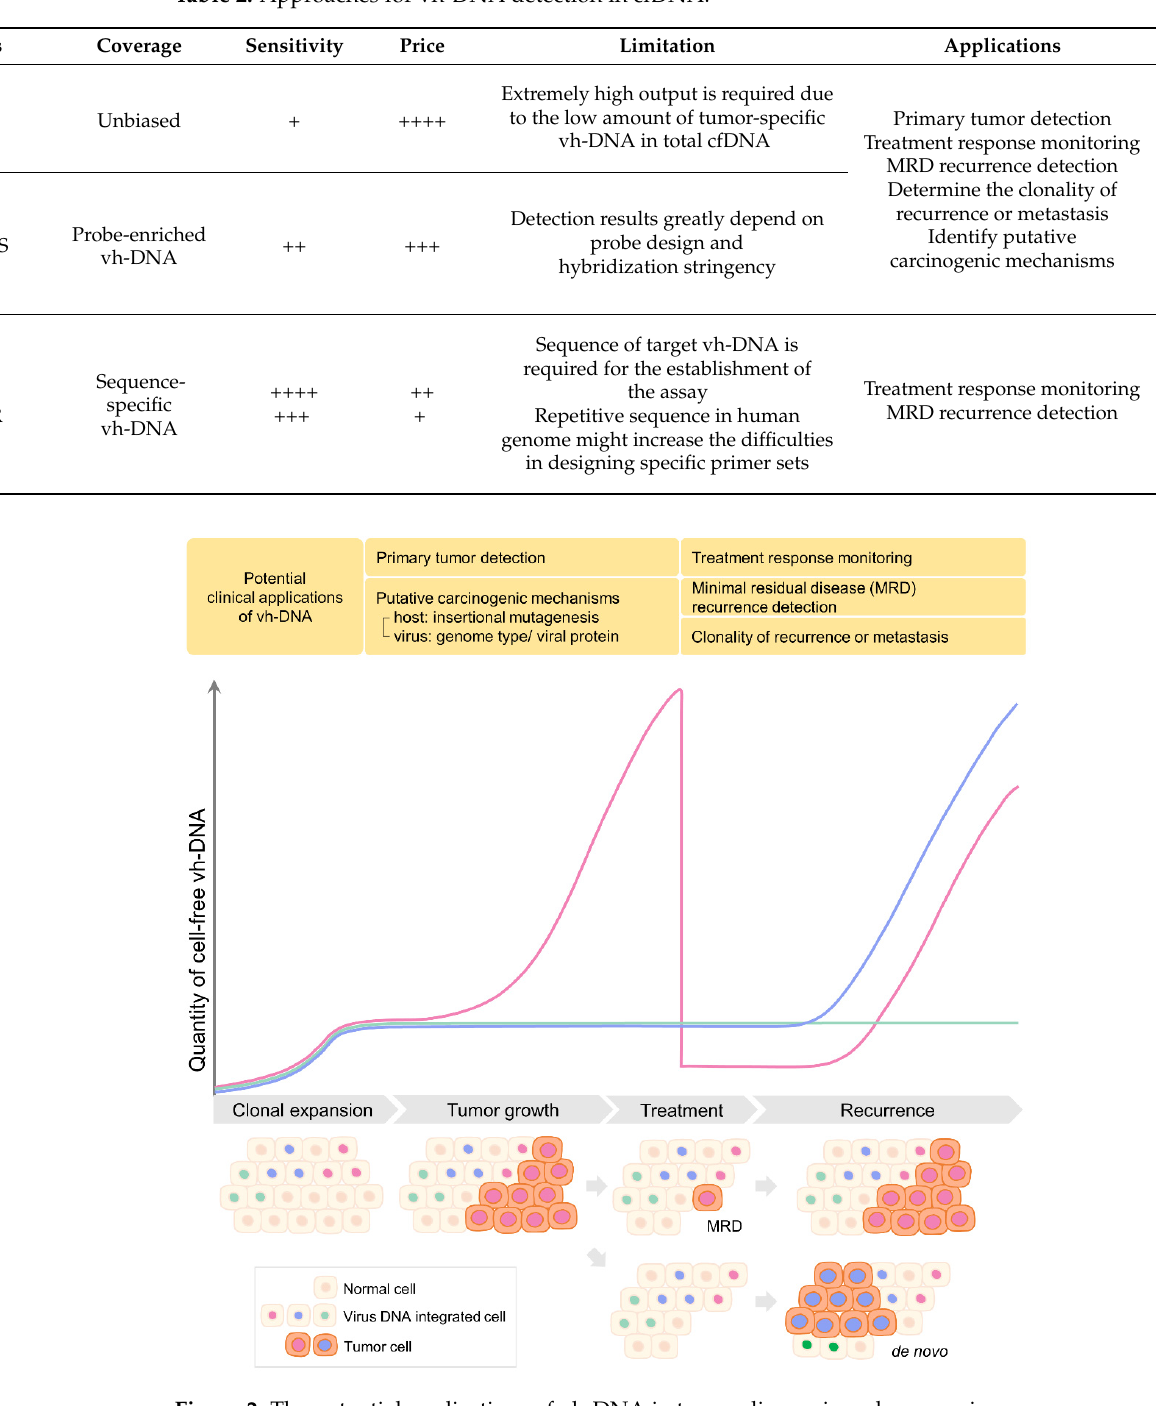
Table 2. Approaches for vh-DNA detection in cfDNA.